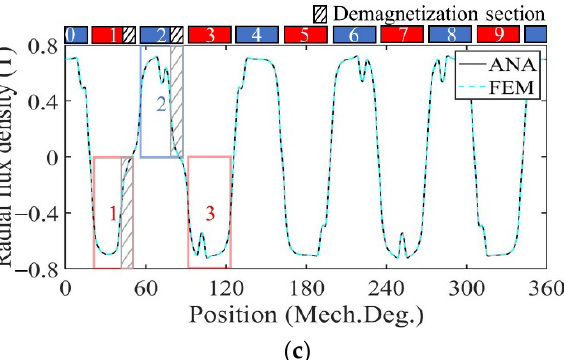
Figure 9. Radial air gap flux density comparison. ( a ) Healthy; ( b ) uniform demagnetization; ( c ) partial demagnetization.